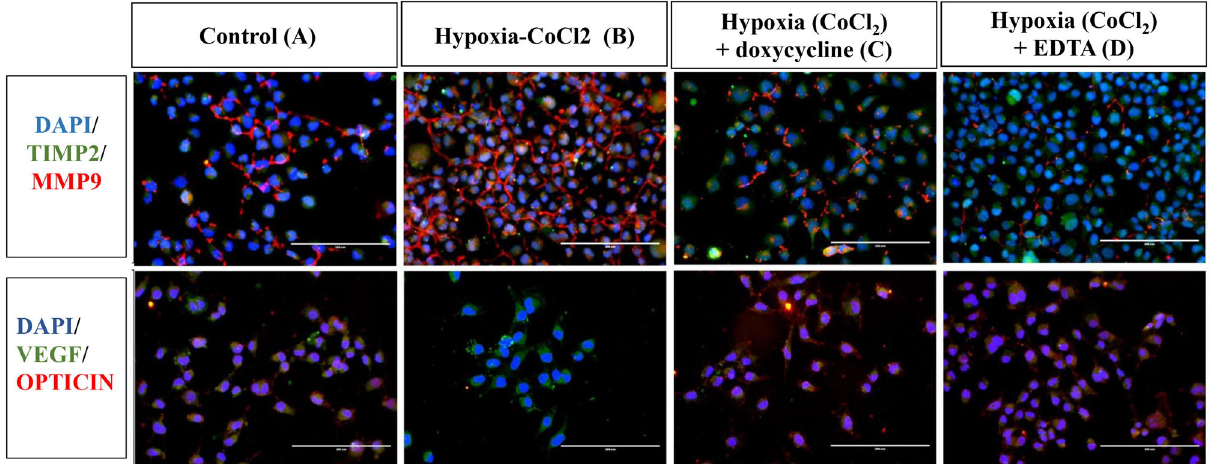
Figure 4. Representative images of immunofluorescence in microglial cells (n = 3, 20× magnified, scale bar 200 μm) showing the expression of MMP9/TIMP2 and VEGF/OPTICIN in control ( A ), hypoxia (CoCl 2 ) ( B ), hypoxia (CoCl 2 ) + doxycycline ( C ), and hypoxia (CoCl 2 ) + EDTA ( D ).